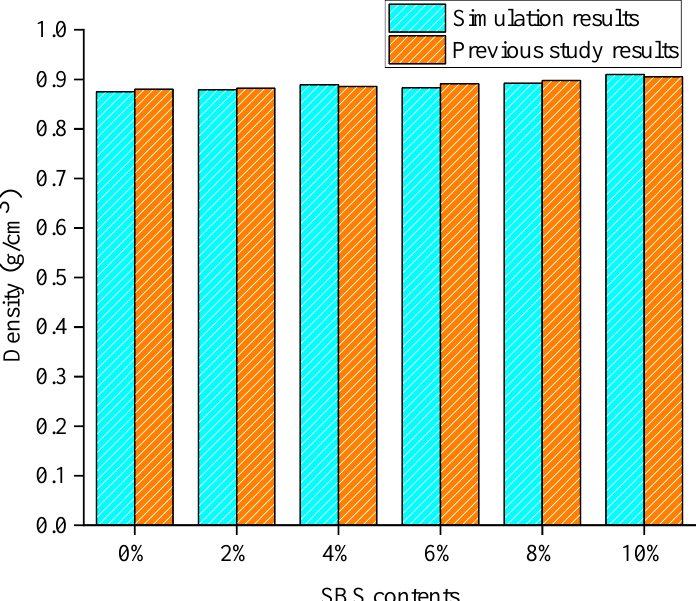
Figure 6. Density of SBS modified asphalt models from the simulation and previous study.